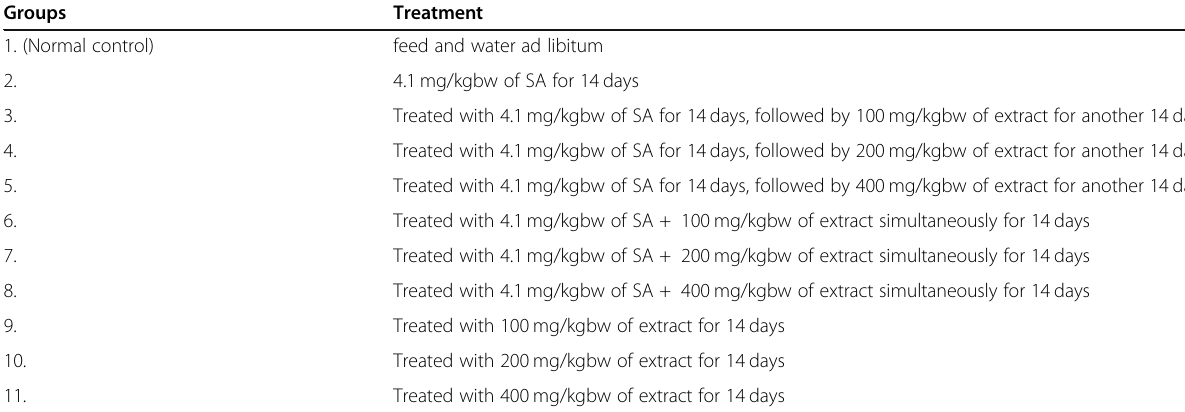
Table 1 Experimental Design Groups